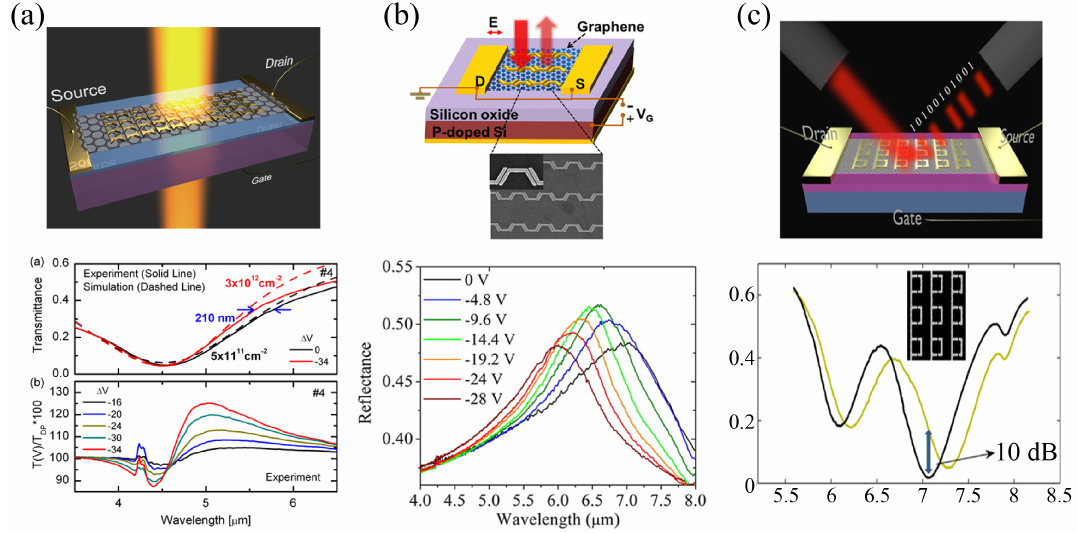
Figure 4: Dynamic modulation of plasmonic resonance at MIR wavelengths using bow-tie antennas (a), staggered nanorods mimicking bond- ing mode in MIM waveguides (b) , and Fano resonant metasurface (c). Figures adapted with permission from references [51, 54], and [56], respectively. Copyright (2012–2014) American Chemical Society.